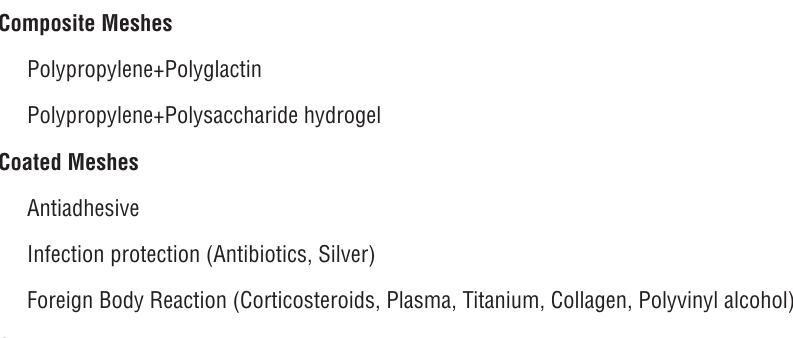
Table 4 - Biomaterials for Reconstructive Surgery-Innovations. Composite